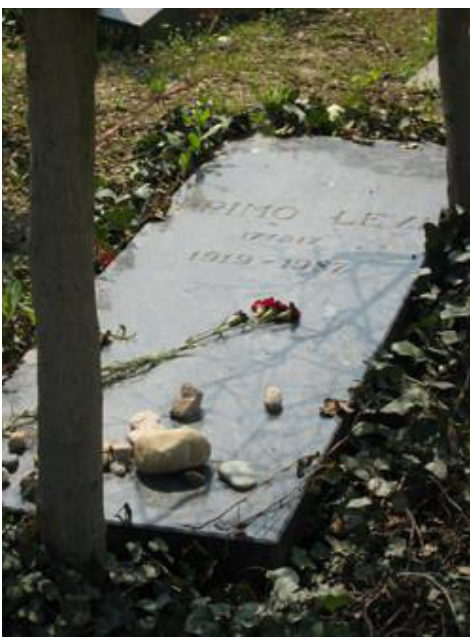
Figure 2. Grave of Primo Levy. Photo from http://www.findagrave.com; reproduced with permission of the photographer, Laura James.